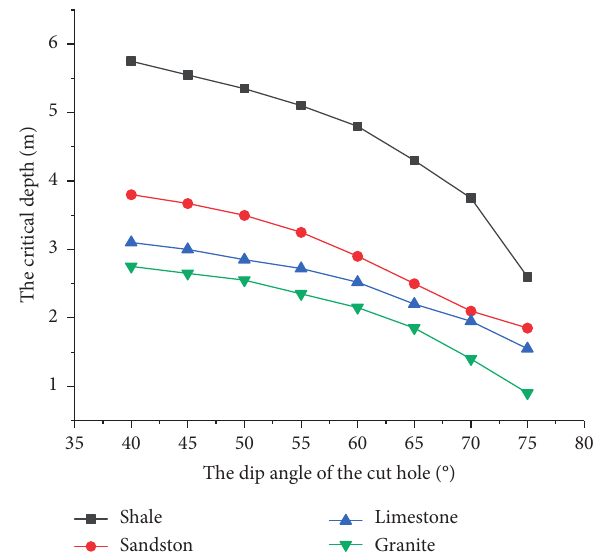
Figure 4: Relationships of critical depths and dip angles of the four types of